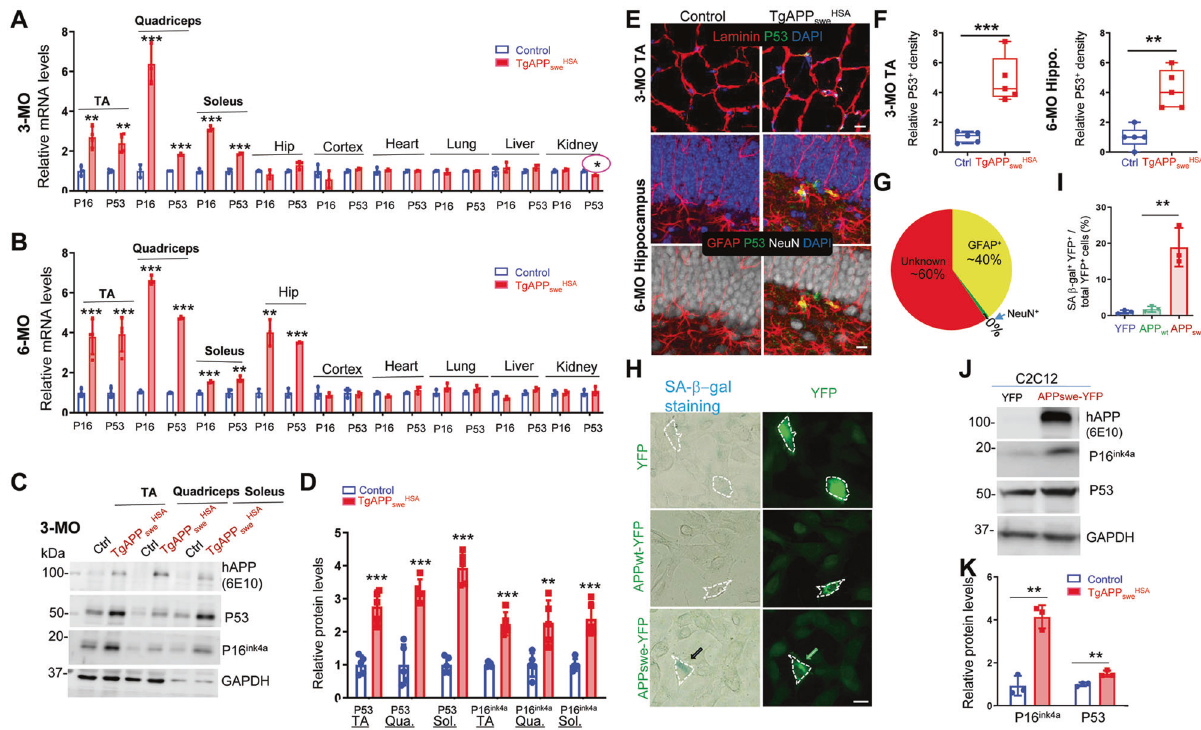
Fig. 6 Increased cellular senescence in TgAPP sweHSA skeletal muscles and APP swe + C2C12 cells. A , B RT-PCR analysis of P16 ink4a and P53 gene expression in indicated tissues/organs of 3-MO ( A ) and 6-MO ( B ) control ( LSL-APP swe ) and TgAPP sweHSA mice. C , D Western blot analysis of indicated protein expression in TA, quadriceps, and soleus from mice at 3-MO. GAPDH was used as a loading control. C Representative blots; and D , quanti fi cation analyses of the data in ( C ). E Representative images of co-immunostaining with p53 (green) with indicated antibodies in the 3-MO TA muscle and 6-MO hippocampus from control and TgAPP sweHSA mice. Scale bars: 20 µm. F , G Quanti fi cation of the data in ( E ). H SA- fi cation of SA- β -gal + β -gal staining of MC3T3 cells transfected with YFP, APP swe -YFP, APP WT -YFP, and YFP plasmids. Scale bar, 20 µm. I Quanti cell densities of data in H ( n = 3 different cultures). J Representative Western blots using antibodies against indicated antibodies in homogenates of C2C12 cells transfected with YFP or APP swe -YFP. GAPDH was used as a loading control. K Quanti fi cation of the data in ( J ). Data in F are shown as box and whiskers. All the data are presented as mean ± SD, n = 3 – 5 mice/group, * p < 0.05, ** p < 0.01, *** p < 0.001, by student ’ s t test in A , B , D , F and K , correction of multiple comparisons using Holm-Sidak method in A , B and D , and One-way ANOVA followed by Turkey ’ s multiple comparison post hoc test in ( I ). The circle with asterisk in ( A )-means with signi fi cant difference, P < 0.05, by t-test, but no signi fi cant change after correction using